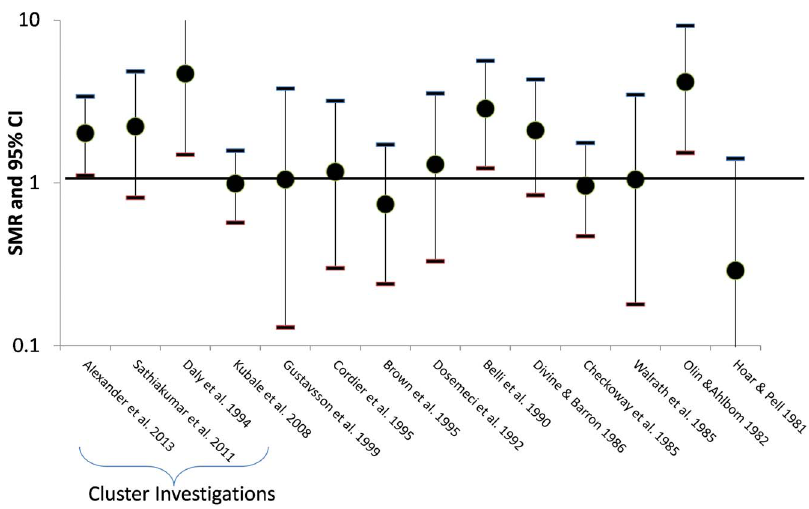
Figure 1. Standardized mortality ratios (SMR) and 95% confidence intervals (95% CI) for studies of laboratory or research workers which report brain